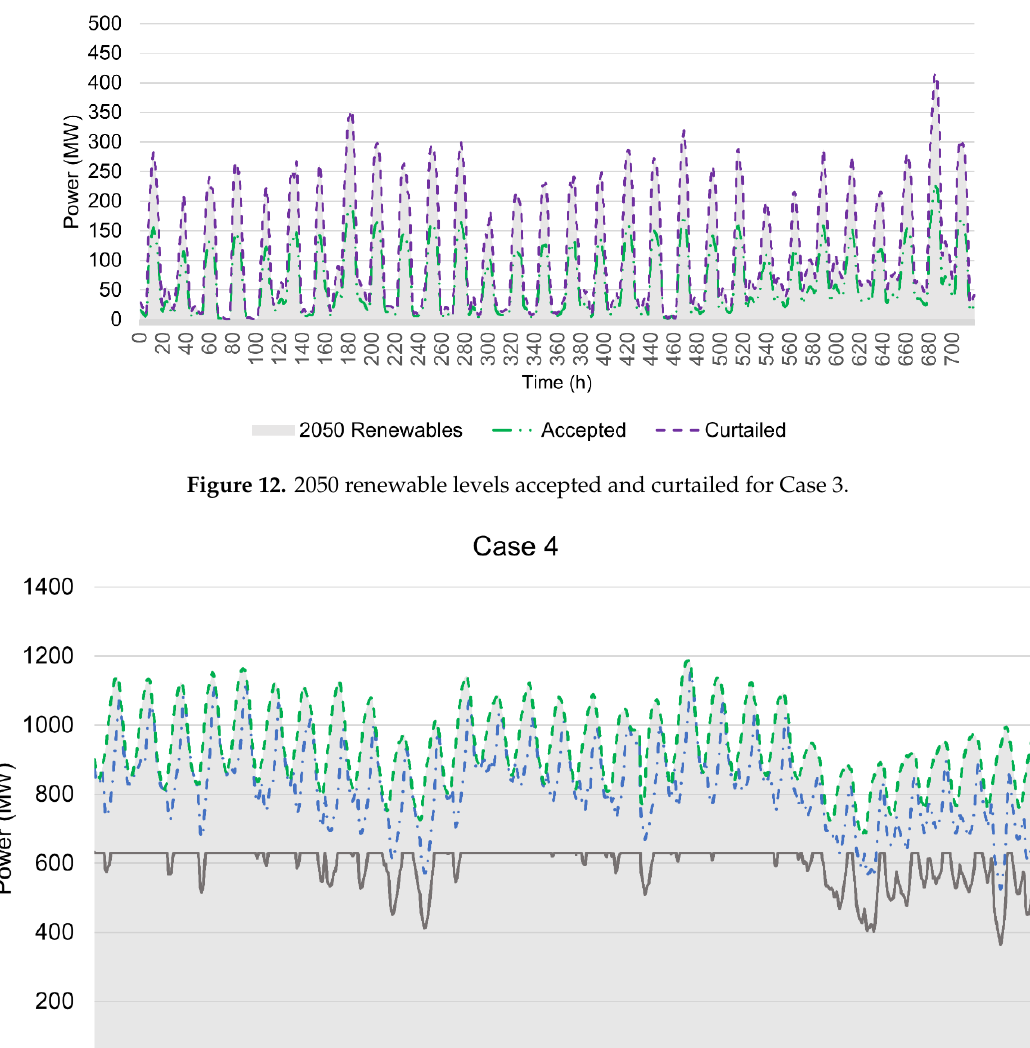
Figure 11. Power dispatch optimization result for Case 3.